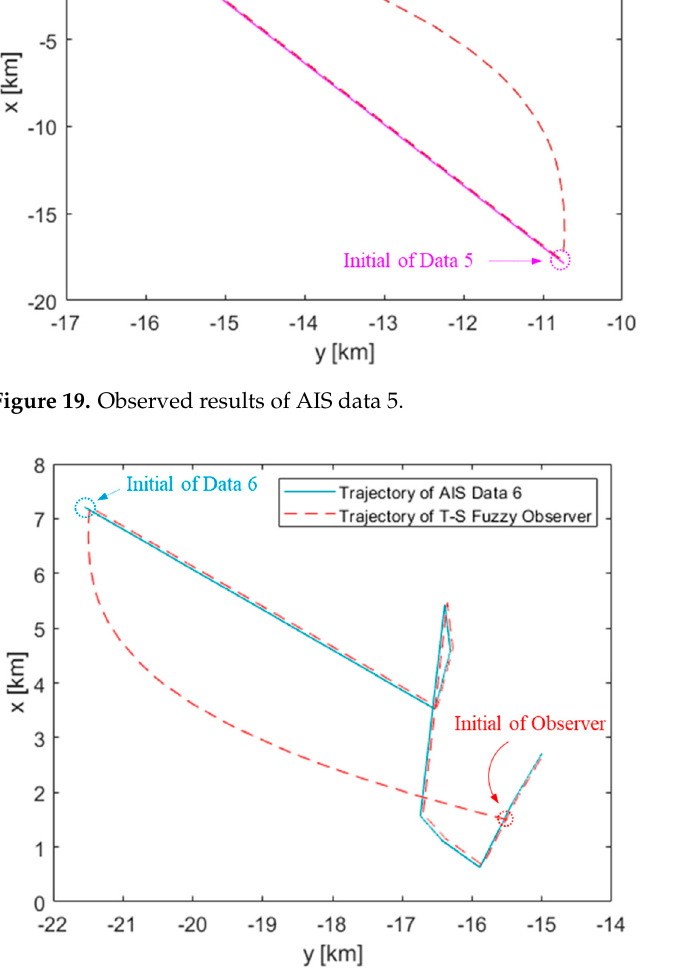
Figure 20. Observed results of AIS data 6.